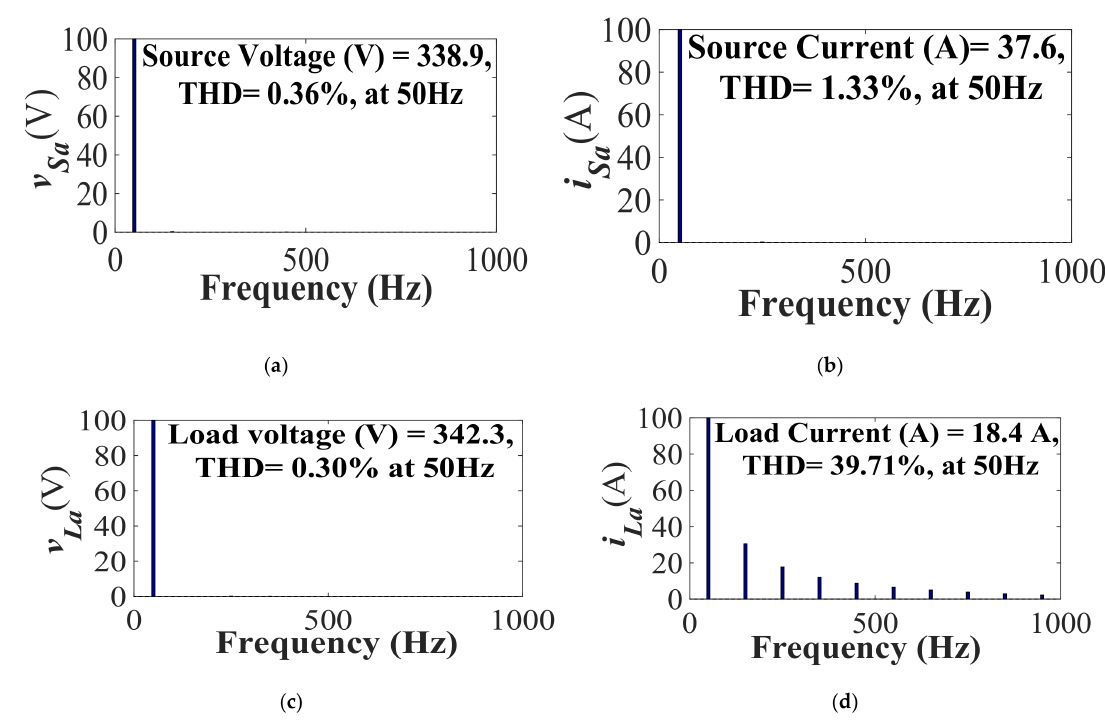
Figure 4. Harmonic content of ( a ) v Sa , ( b ) i Sa , ( c ) v Sa , and ( d ) i La during steady-state.